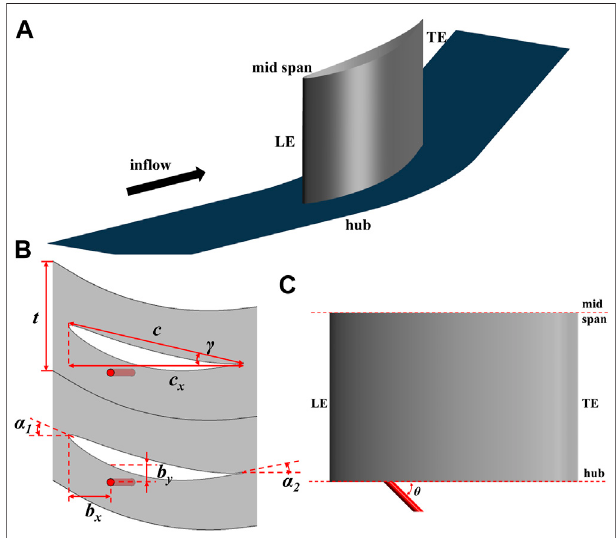
FIGURE1 | Schematic diagram ofthe calculation model. (A) Calculation modeldisplay; (B) thede fi nitionofthesymbols; (C) theinclinationanglede fi ne the hole.